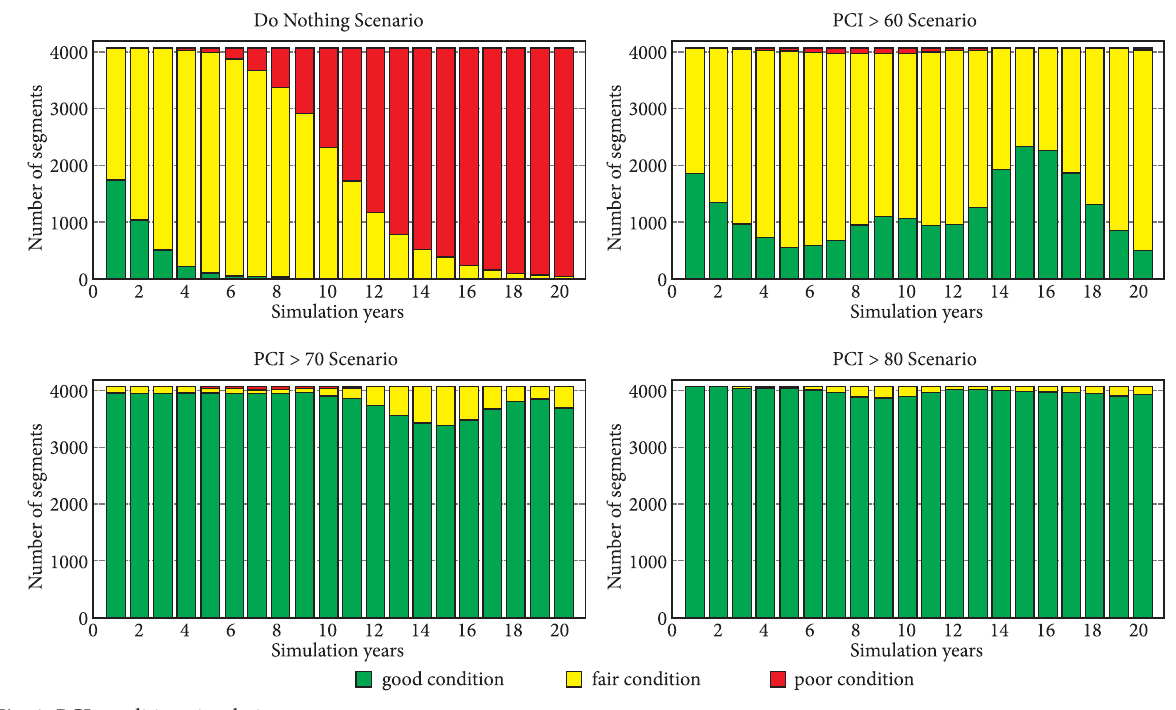
Fig. 9. PCI condition